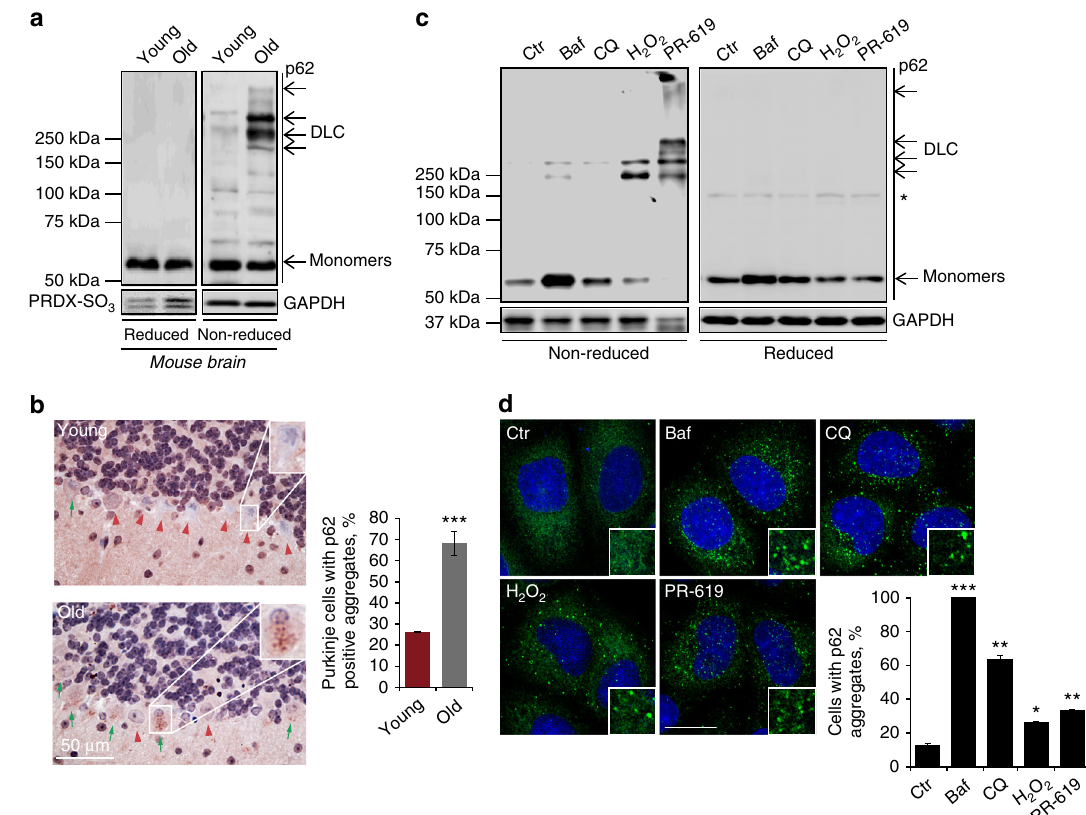
Fig. 1 p62 forms oligomers and aggregates in response to oxidation. a Mouse brain tissue, young (3 months) and old (24 months) analysed by immunoblotting for p62, PRDX-SO 3 and actin as a loading control in reducing (2.5% β -ME) and non-reducing conditions. DLC disulphide-linked conjugates. Arrows indicate the positions of monomeric and oligomeric p62. b Representative images and quanti fi cation of p62 aggregates in old mouse Purkinje cells in the cerebellum. Green arrows and red arrowheads indicate Purkinje cells positive and negative for p62 aggregates, respectively. c Effect of autophagy inhibition (ba fi lomycin A1 (Baf, 400 nM, 4 h) and chloroquine (CQ, 50 μ M, 4 h)) and oxidative stress (H 2 O 2 (3 mM, 10 min) and PR-619 (5 μ M, 30 min)) on p62 DLC ( c ) and p62 aggregation ( d ) in HeLa cells. d Anti-p62 staining analysed by confocal microscopy. Error bars represent s.e.m., n = 3 , * P < 0.05, ** P < 0.01, *** P < 0.005 (unpaired t -tests). Asterisk indicates a non-speci fi c band. Scale bar: 20 µ